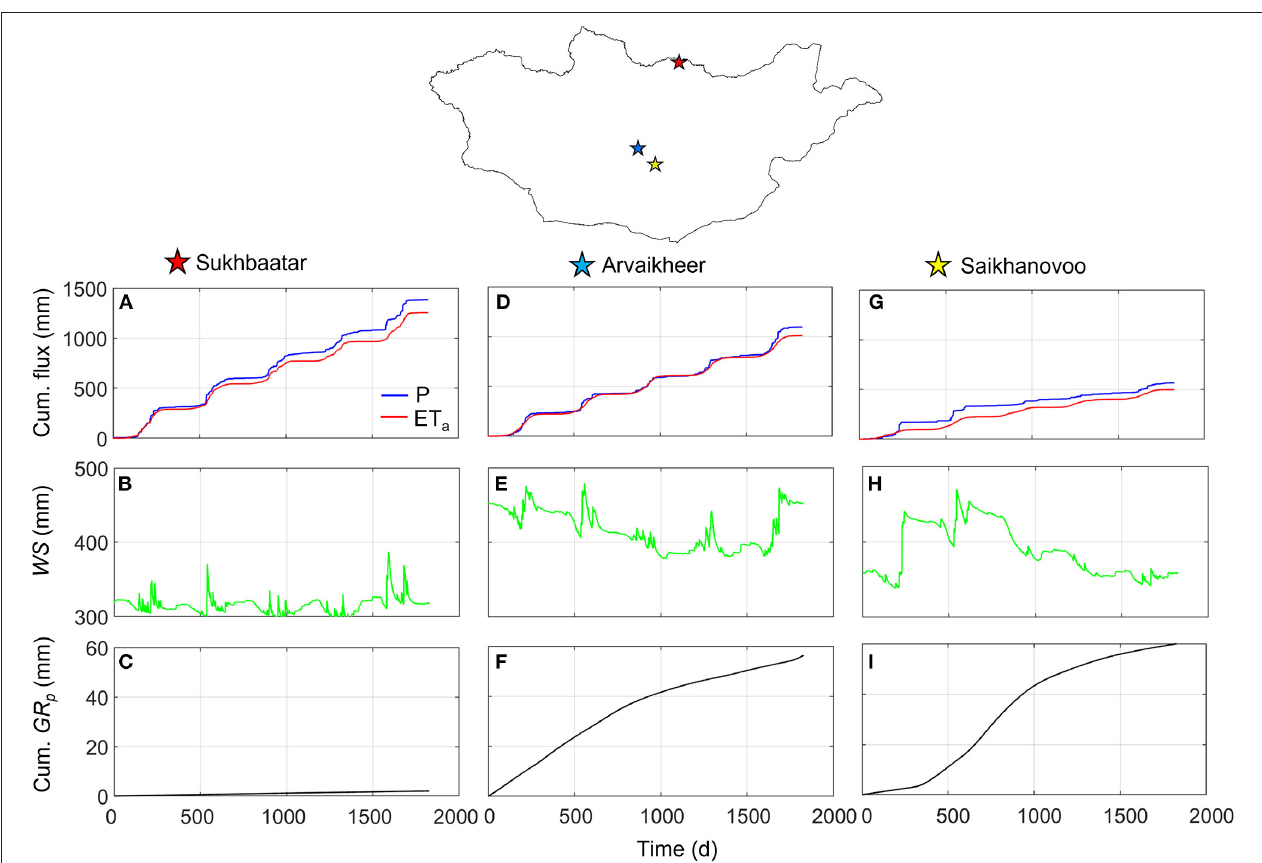
FIGURE 2 | Cumulative net precipitation (blue line), cumulative actual evapotranspiration (red line), water storage, WS (green line), and cumulative potential groundwater recharge GR p (black line) at (A–C) Sukhbaatar, (D–F) Arvaikheer, and (G–I)